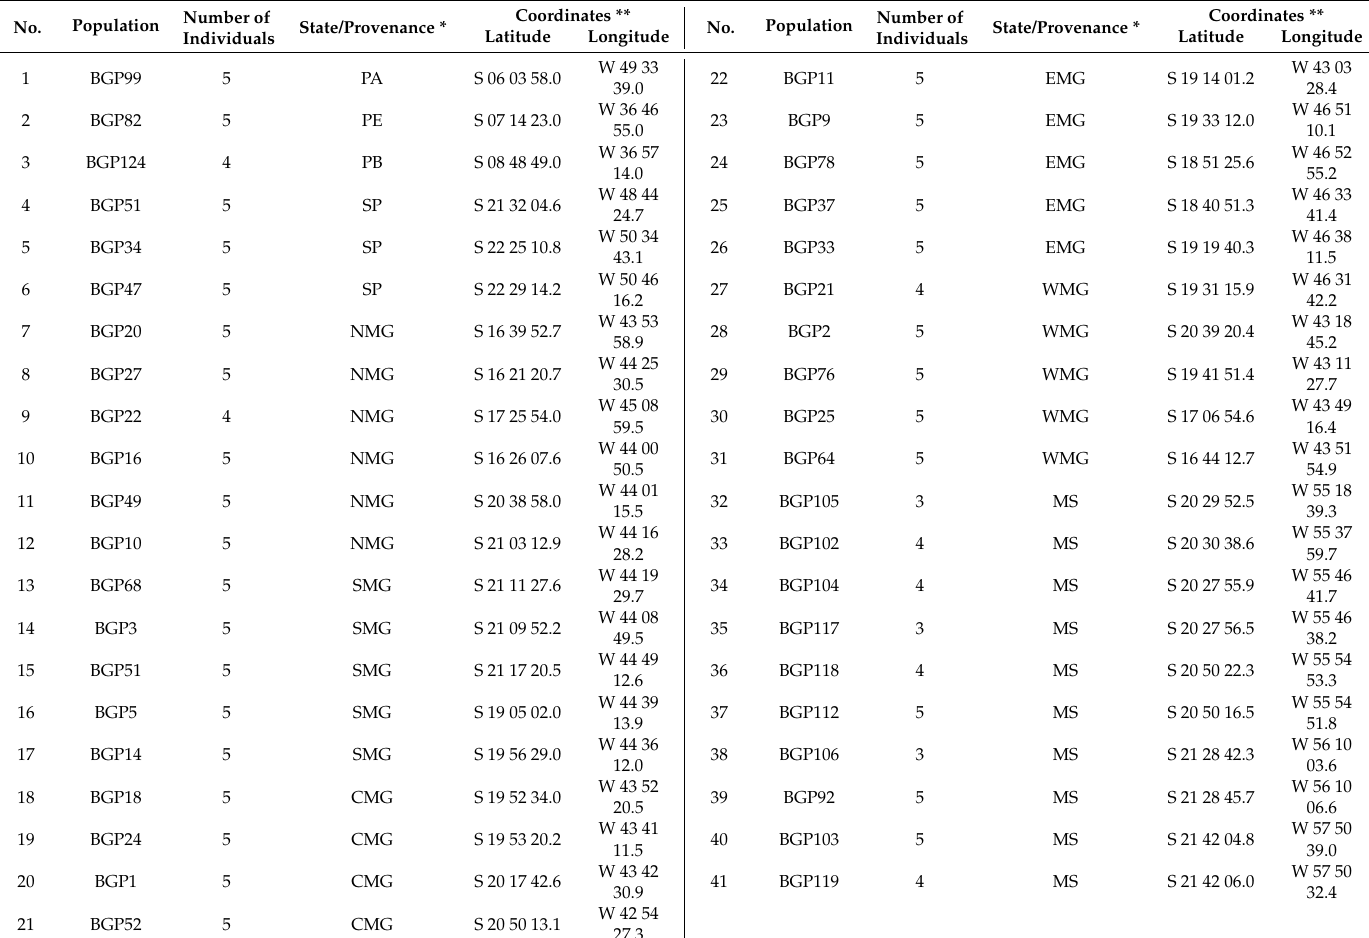
Table 1. List of 41 Acrocomia aculeata populations, number of individuals, states (or provenances), and GPS